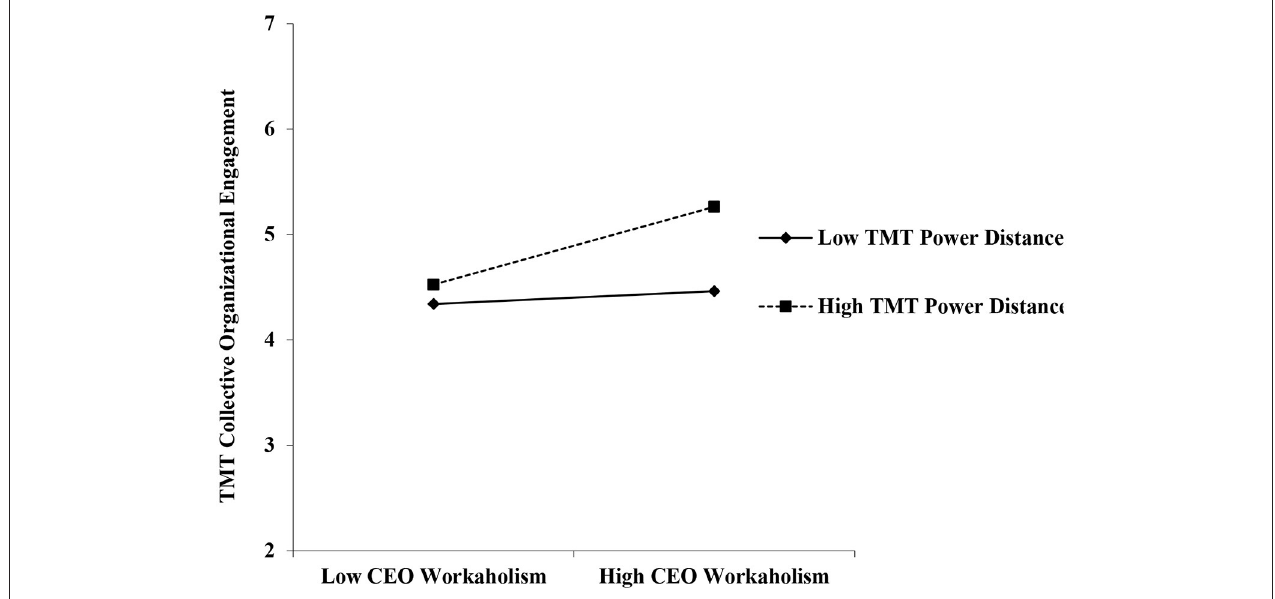
FIGURE 2 | Moderating effect of TMT power distance on the relationship between CEO Workaholism and TMT collective organizational engagement.